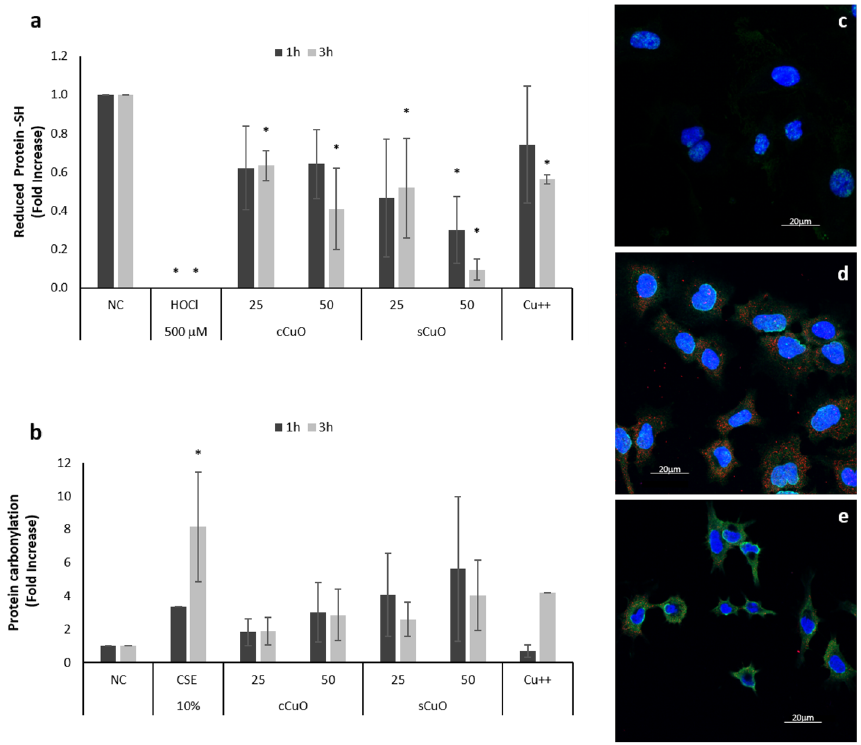
Figure 4. Short-term oxidative stress markers in A549. Histograms ( a , b ) show the results obtained by immunoblotting after the exposure of cells to cCuO and sCuO for 1 h (dark grey bars) and 3 h (light grey bars) about the quantification of ( a ) Reduced protein thiols; ( b ) Protein carbonylation (PCO). NC) Negative Control (unexposed cells); HOCl = 500 µM sodium hypochlorite; CSE = 10% condensate smoke extract; Cu ++ = 80 µg/ml copper from CuSO 4 ·5H 2 O. Results are expressed as mean ± SD. *Significantly different from control (ANOVA + Fischer LSD Method, p < 0,05). The pictures ( c – e ) show the immunocytochemical detection of protein carbonyls by confocal laser scanning microscopy (CLSM) after 3 h of exposure; ( c ) negative control cells; ( d ) cCuO-exposed cells; ( e ) sCuO-exposed cells. Nuclei are stained by Hoechst (blue spots); CuO NPs are mapped by reflection mode (pseudocolored red spots); protein carbonyls were immunostained with anti-DNP (green